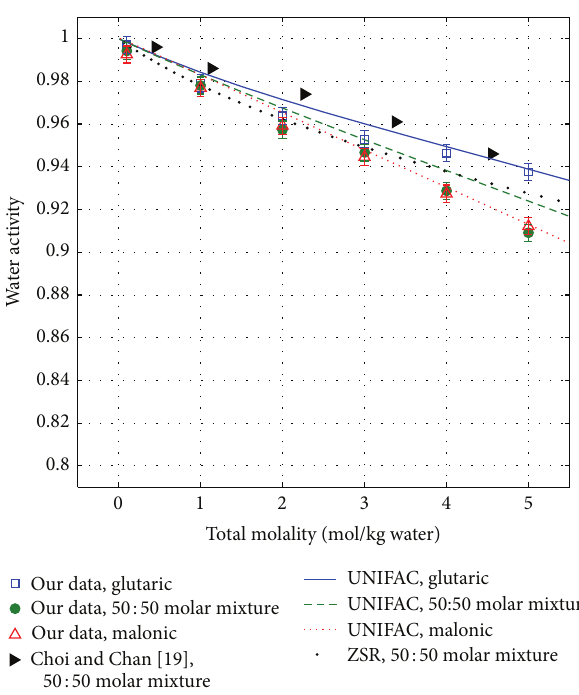
Figure 3: Water activity of malonic acid, glutaric acid and their equal molar mixture. Each data point represents the average of 4 replicate measurements; error bars on measured data represent standard deviation of